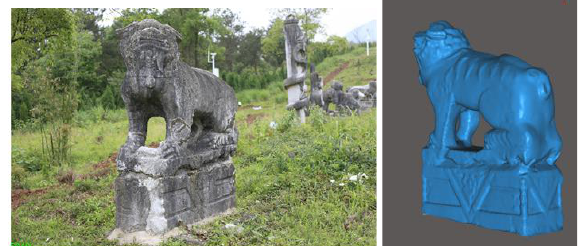
Figure 1. Test Dataset I: a stone lion in natural environment. (a) Image of stone sculpture collected by Canon camera; (b) geometric